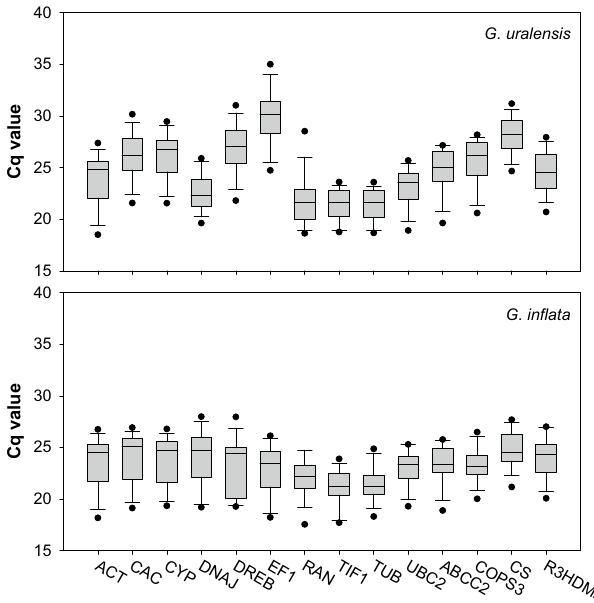
Figure 2. Distribution of threshold cycle (Cq) values for candidate reference genes. Distribution of threshold cycle (Cq) values of G. uralensis and G. inflata in all samples. Boxes: the interquartile range; lines across the boxes: median; lines above and below the boxes: the maximum and minimum values; black dots: